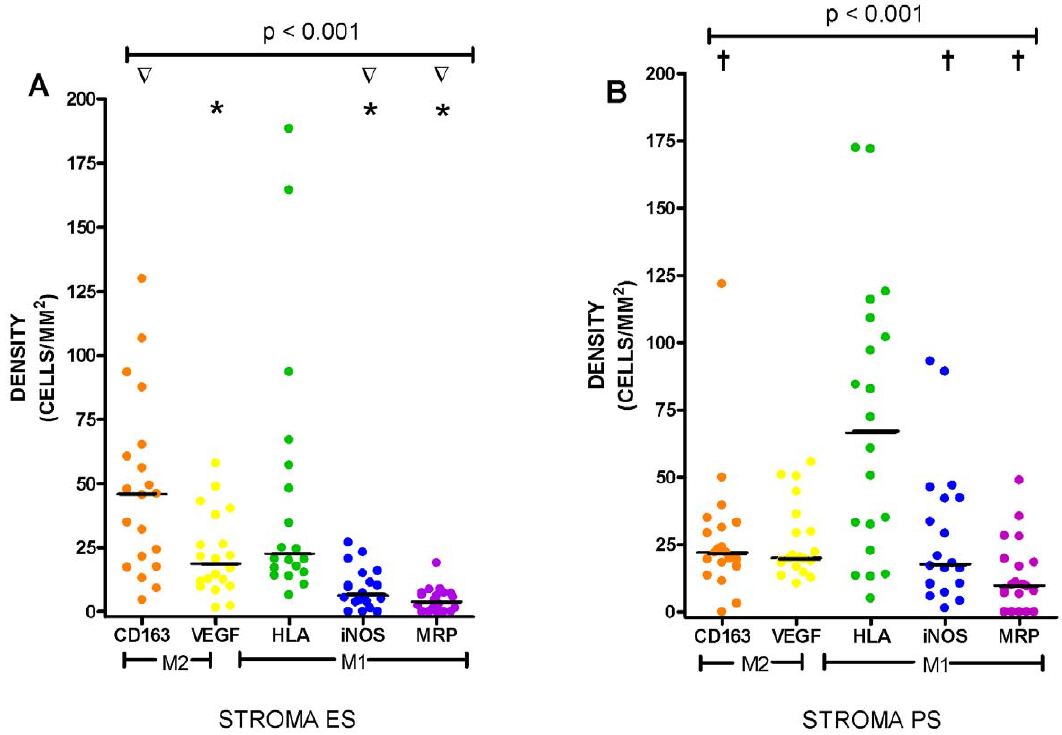
Figure 3. Non-macrophage double-stain densities in the stroma in (A) extended survival (ES), and (B) poor survival (PS). * represents a significant difference (p , 0.05) in expression compared with CD163. = represents a significant difference (p , 0.05) in expression compared with VEGF. { represents a significant difference (p , 0.05) between the corresponding marker in the ES group.